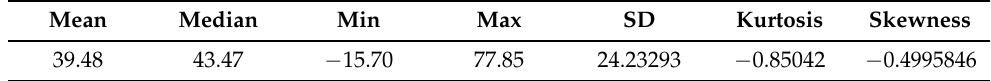
Table 11. Statistical characteristics of the “Average Temperature” dataset.